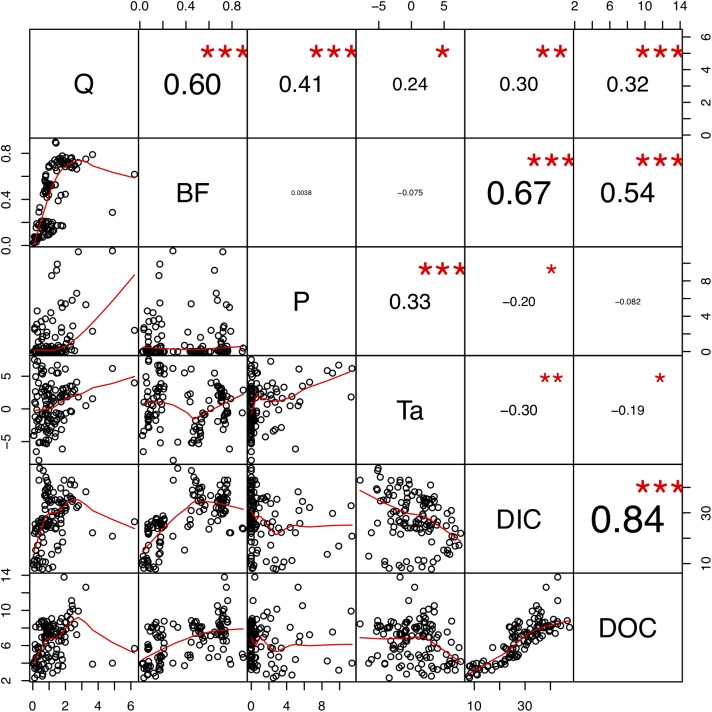
Correlation matrix plot indicate relationships of dissolved carbon concentrations and hydrological and meteorological factors.The upper panel shows positive and negative Pearson’s correlation coefficients in different size (larger represent higher values). Note significance values: *p ≤ 0.05; **p ≤ 0.01; and ***p ≤ 0.001. The red lines in lower panel are scaled kernel regression smoothers indicating potential linear and non-linear relationships. Q, discharge; BF, baseflow; P, precipitation; Ta, air temperature in °C.